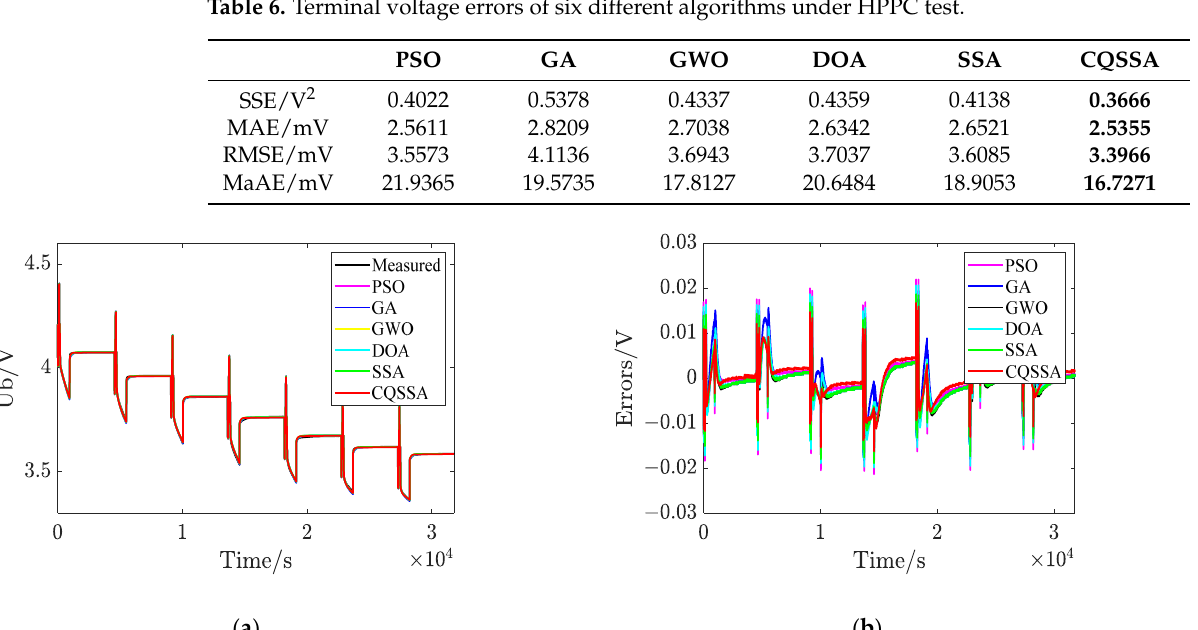
Table 6. Terminal voltage errors of six different algorithms under HPPC test.